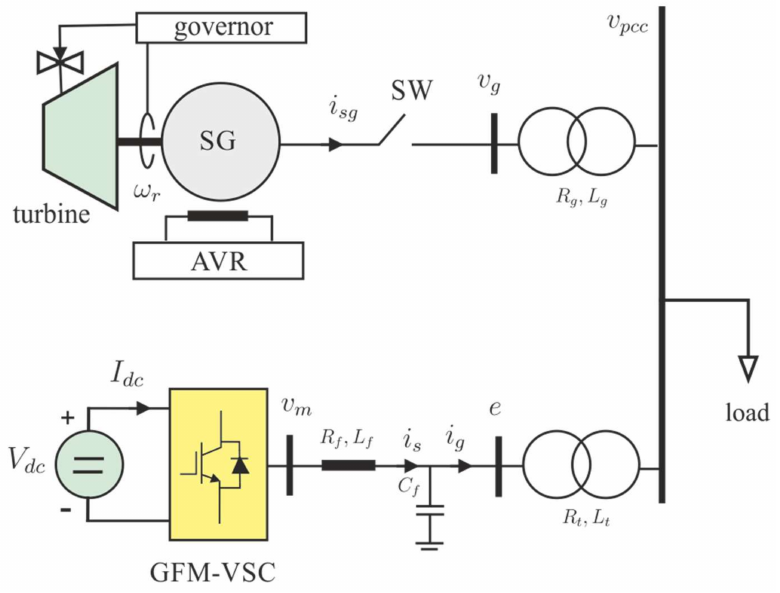
Figure 13. Schematic of the plant designed in